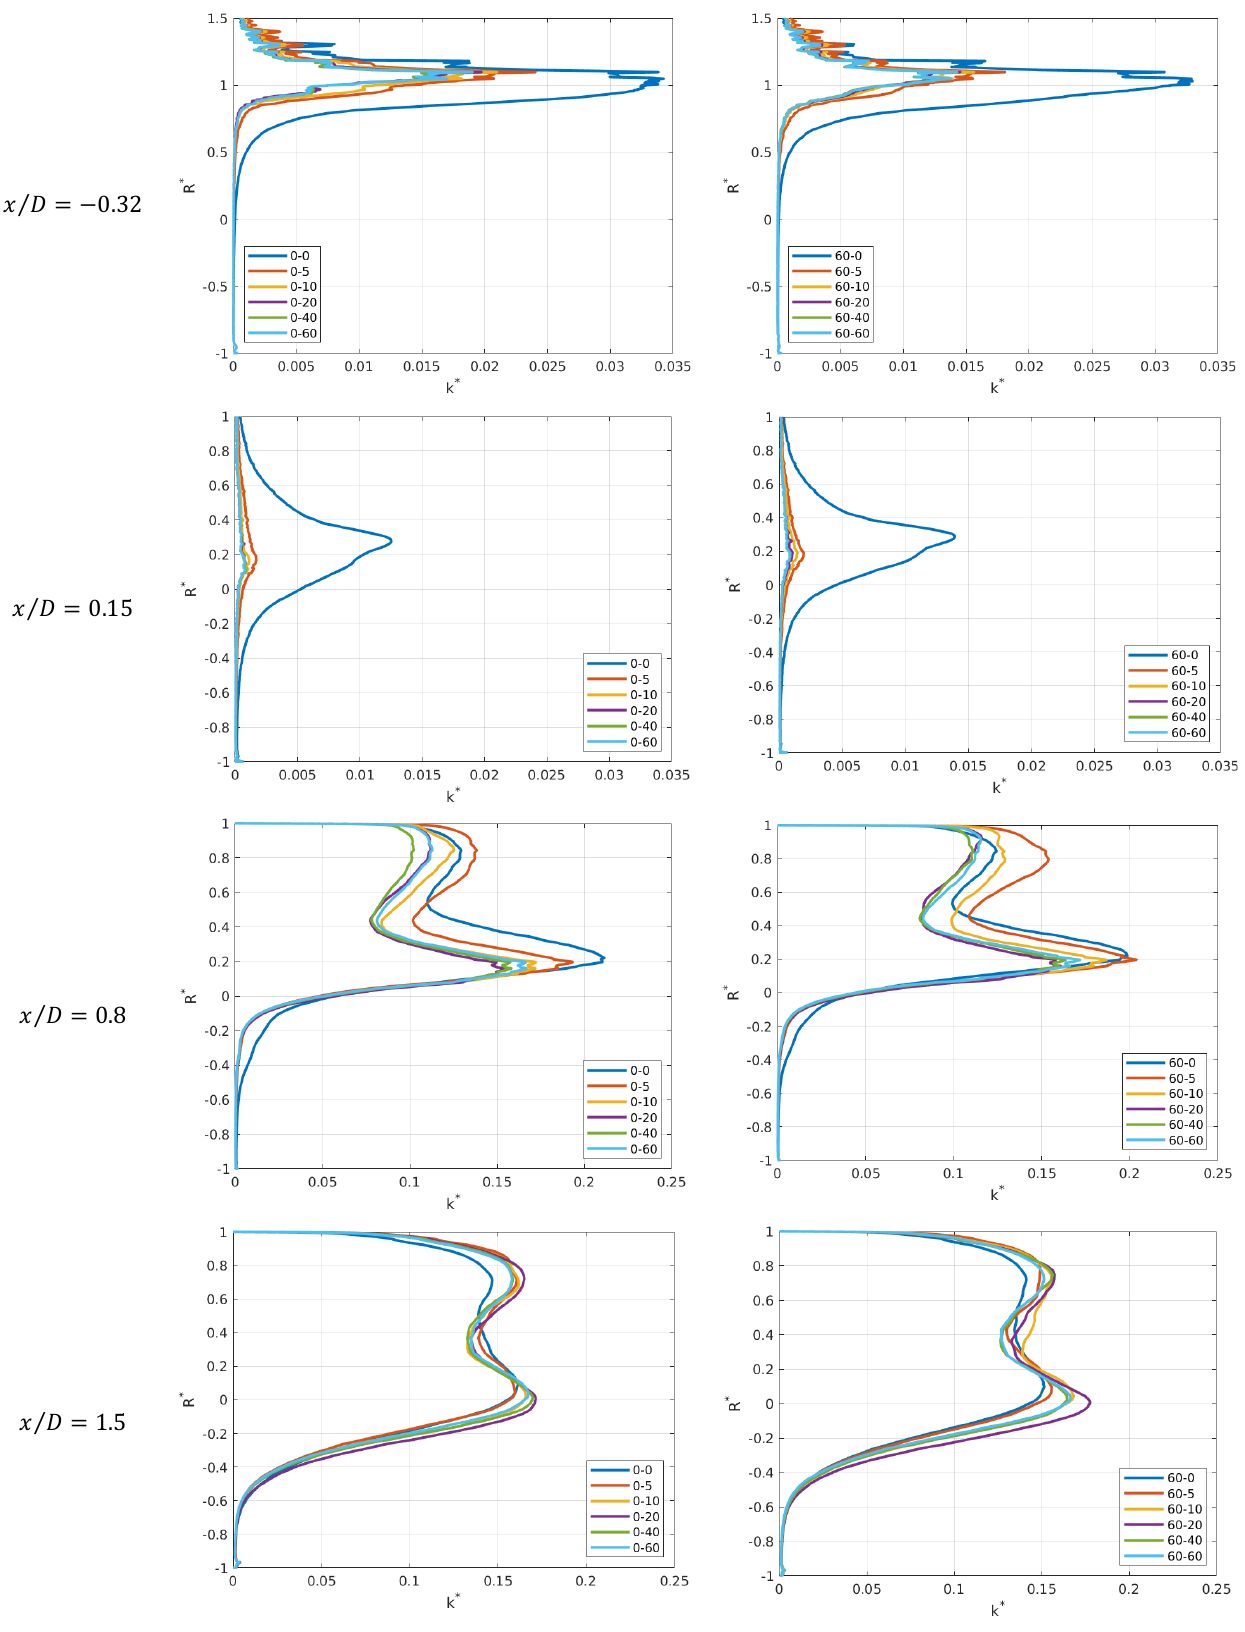
Figure 9. Vertical profiles of 𝑘 ∗ at different cross-sections.